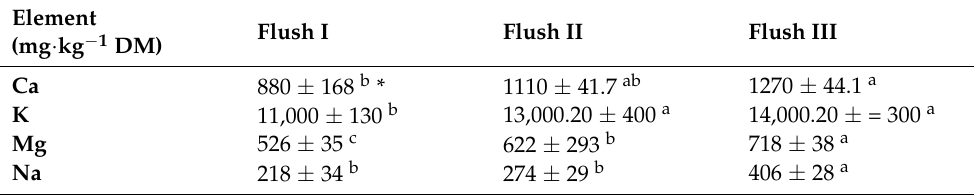
Table 3. Concentrations of MEEs in the fruiting bodies of P. djamor cultivated on EMS.